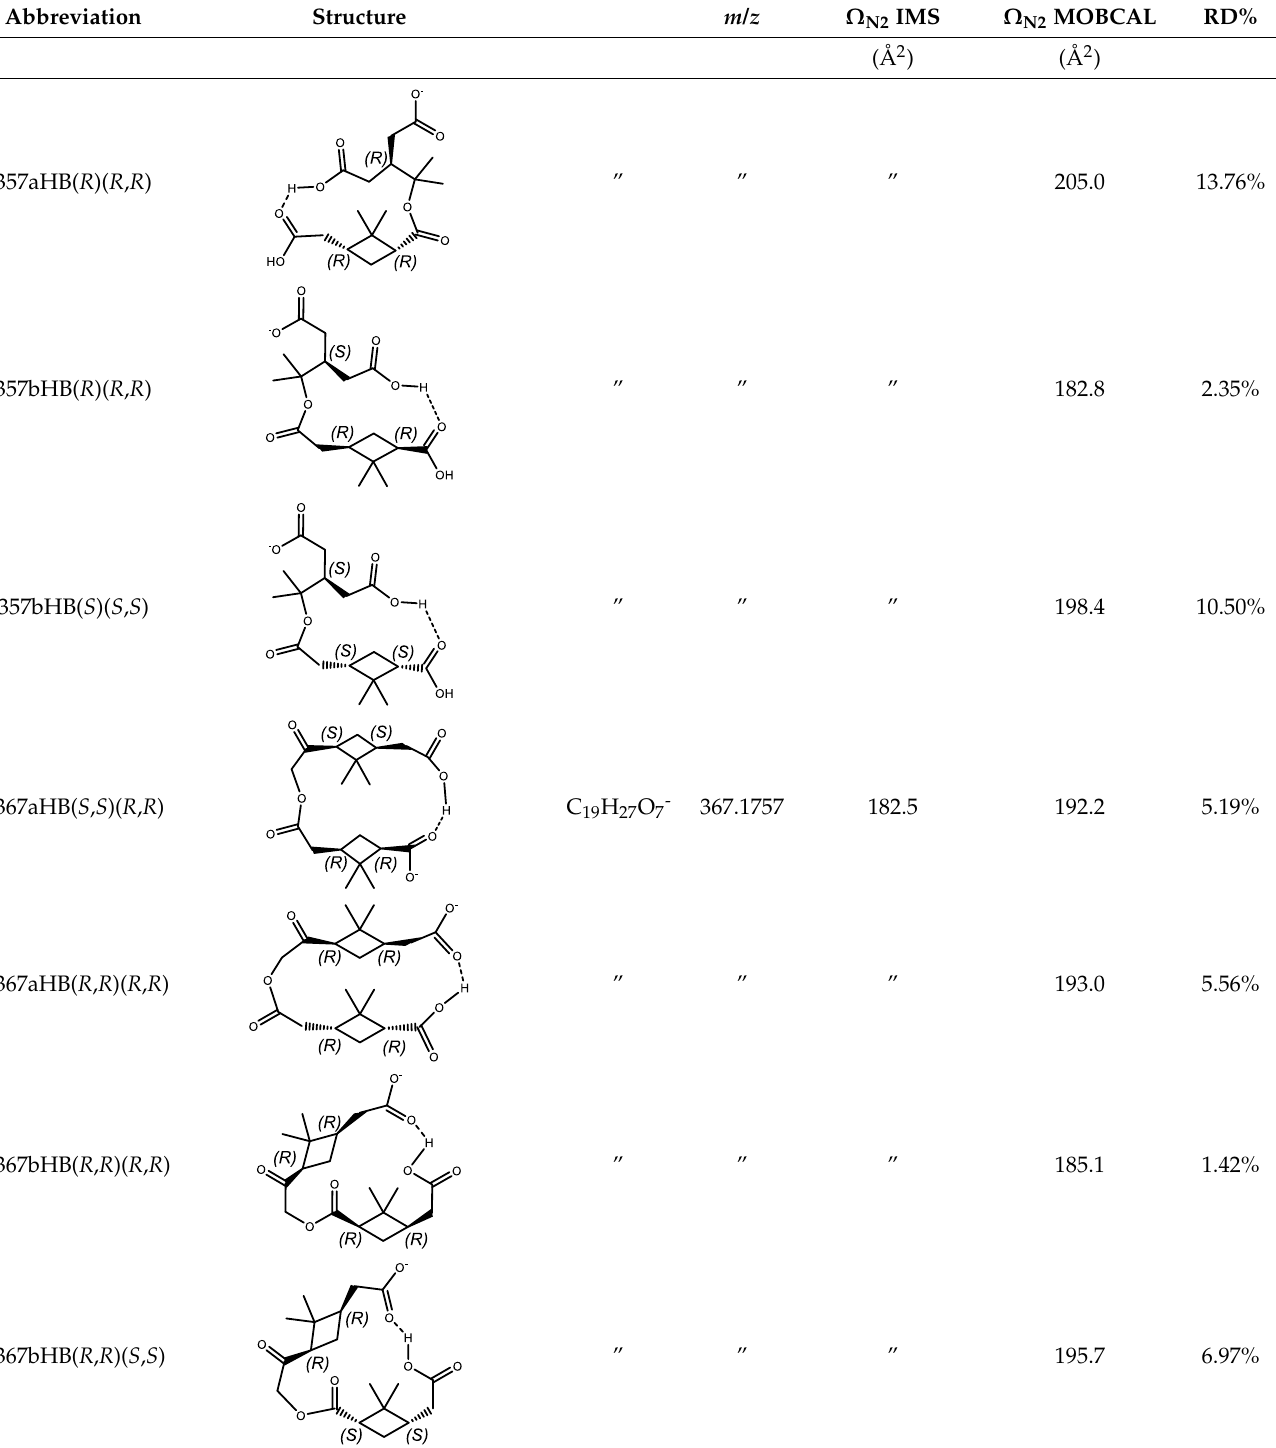
Table 4. Structures and Ω N2 values of m / z 357 and m / z 367 ions with an intra-molecular hydrogen bond considered in this